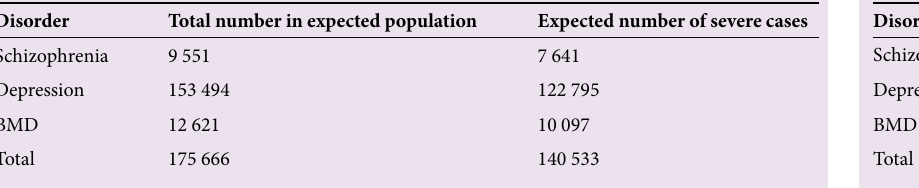
Table 4. Target population at 80% coverage Table 5. Expected annual ambulatory visits